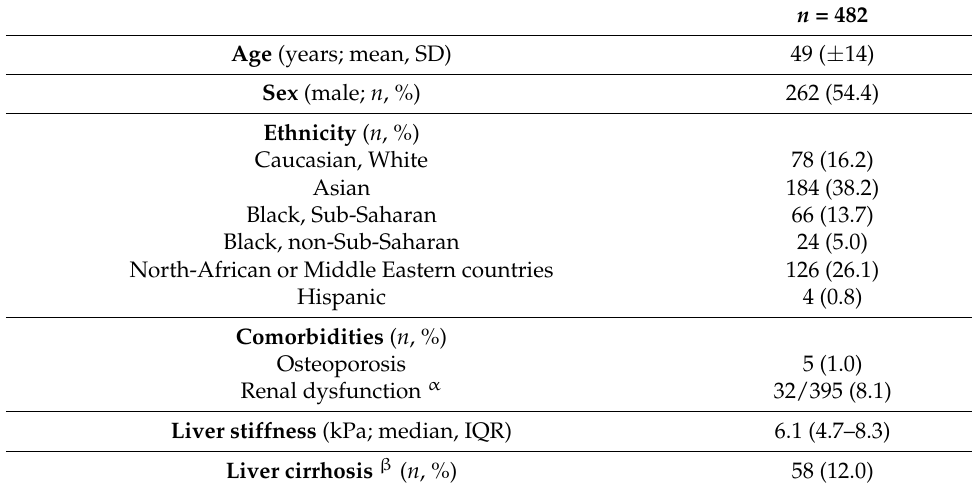
Table 1. Patient